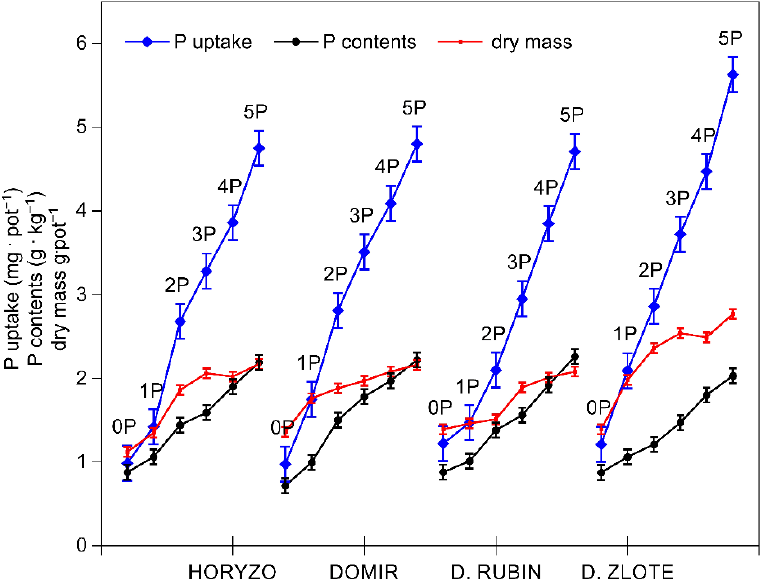
Figure 2. Changes in the phosphorus (P) uptake and concentration, and the dry mass accumulation in shoots of rye varieties grown on the post-flotation sediment. Plants were supplemented with 0 (0P), 22 (1P), 44 (2P), 66 (3P), 88 (4P), and 110 (5P) mg P·kg − 1 . The shoot tissue samples were collected 28 DAS at the BBCH 12 stage, dried, and used to determine P concentrations and dry mass. Data represent the means of n = 9 replications, and vertical bars represent 95% confidence interval after a post hoc Tukey HSD test (interaction P dose × variety), with the letters denoting homogeneous groups being omitted for a clear view.